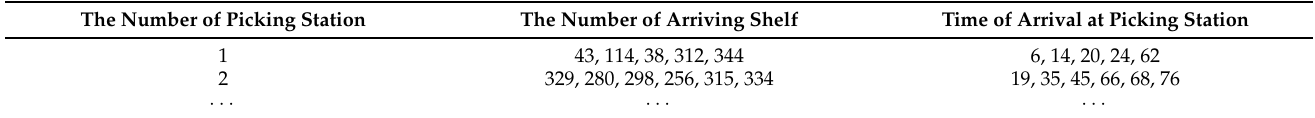
Table 7. AGV arrival data of each picking station (Part).